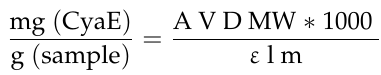
Supplementary Materials: Figure S1: NMR analyses of Omnivin WG ( Vv ): (A) 31 P NMR; (B) 1 H- 13 C HSQC, Figure S2: MALDI-ToF analysis of Omnivin WG ( Vv ). Figure S3: NMR analyses of Omnivin R ( Vv-R ): (A) 31 P NMR; (B) 1 H- 13 C HSQC. Figure S4: MALDI-ToF analysis of Omnivin R ( Vv-R ). Figure S5: NMR analyses of Omnivin 10R ( Vv -10 ): (A) 31 P NMR; (B) 1 H- 13 C HSQC. Figure S6: MALDI-ToF analysis of Omnivin 10R ( Vv -10 ). Figure S7: NMR analyses of Omnivin R20 ( Vv -20 ): (A) 31 P NMR; (B) 1 H- 13 C HSQC. Figure S8: MALDI-ToF analysis of Omnivin 20R ( Vv -20 ). Figure S9: NMR analyses of MIMOSA ATO ME ( Am ): (A) 31 P NMR; (B) 1 H- 13 C HSQC. Figure S10: MALDI-ToF analysis of MIMOSA ATO ME ( Am ). Figure S11: NMR analyses of QUEBRACHO ATO ( Sb ): (A) 31 P NMR; (B) 1 H- 13 C HSQC. Figure S12: MALDI-ToF analyses of QUEBRACHO